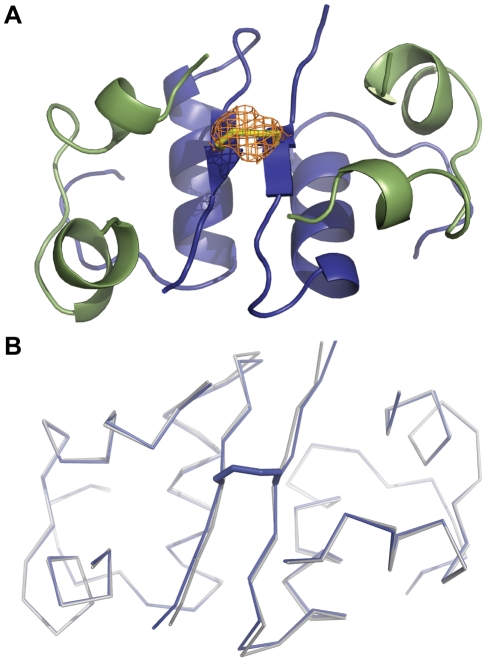
Cartoon representation of the crystal structure of the B25C-dimer.
A: The A chain is coloured in green and the B chain is shown in blue. The additional disulphide bond is shown by stick representation (yellow). An omit map was calculated by omitting the Sulphur atom of B25C. The resulting difference electron density Fo-Fc map is coloured in orange at σ-level = 3.0. It is clear from the structure that the two monomers are linked by a disulfide bond between the two adjoining B25C. B: Comparison of the B25C structure (blue) with that of the porcine in-sulin (PDB code 1B2E) (grey). The Cα trace shows that the two structures have a high resemblance with minor deviations in Cα positions at residue B21E and B29K.